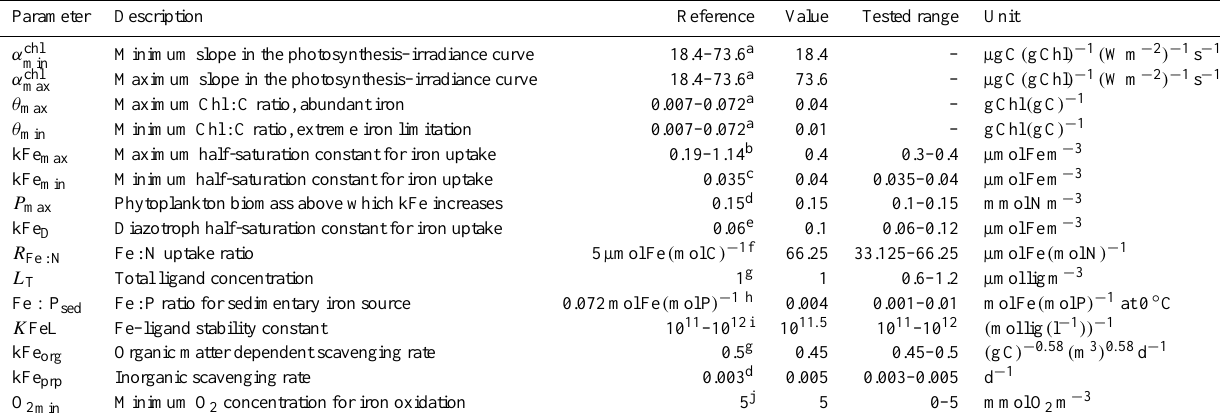
Table 1. Parameters that are new or different from Keller et al. (2012) with parameter name, description, value, range tested and unit. References for the parameters are given as footnotes. If no units are given in the reference column, reference units are equal to model units given in the last